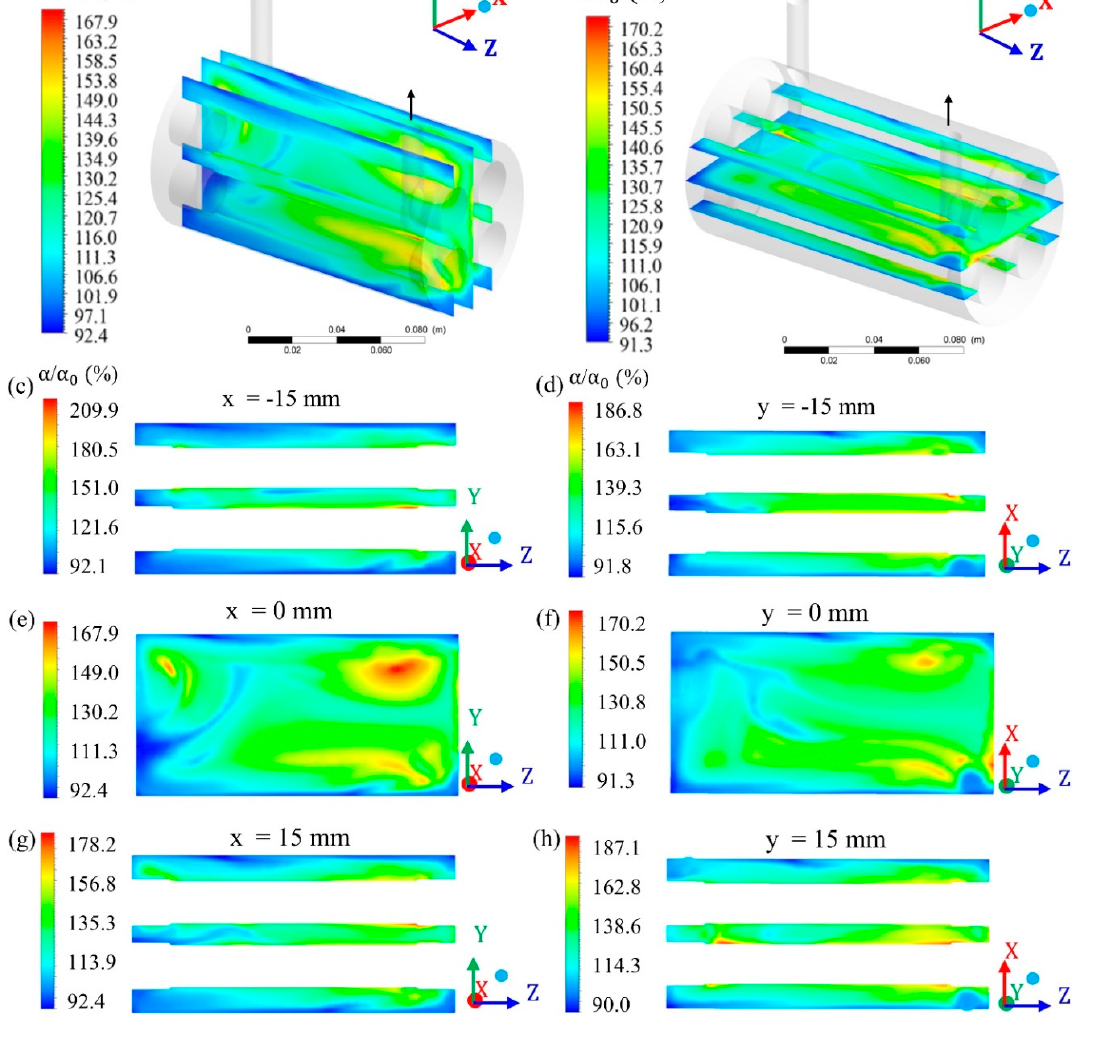
Figure 8. Field of relative oil volumetric fraction in different regions of the hull: ( a ) In the yz plane at x = − 15 mm, x = 0 mm and x = 15 mm; ( b ) in the xz plane at y = − 15 mm, y = 0 mm and y = 15 mm; ( c ) x = − 15 mm; ( d ) y = − 15 mm; ( e ) x = 0 mm; ( f ) y = 0 mm; ( g ) x = 15 mm and ( h ) y = 15 mm, of the filtration module during the water / oil separation process.